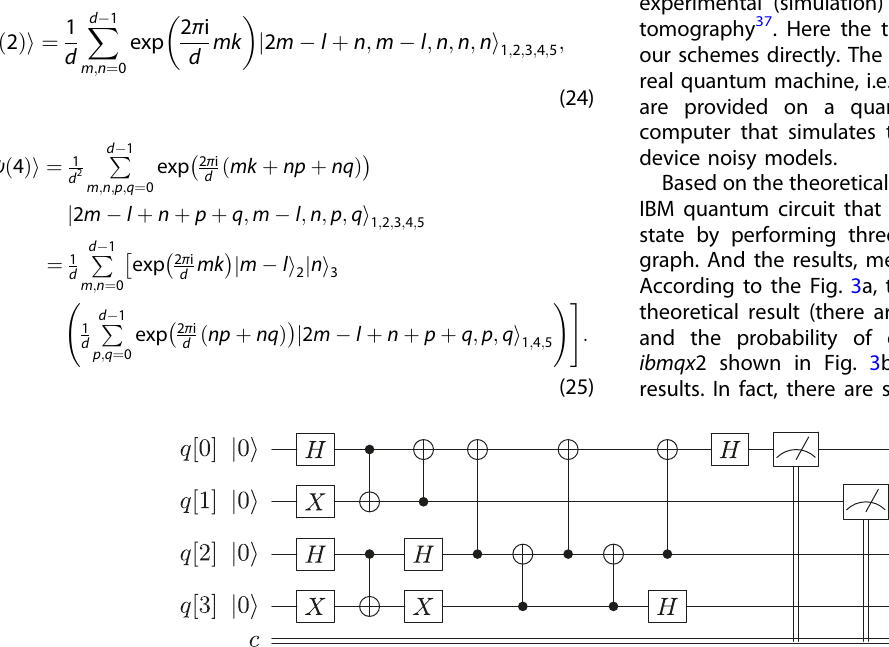
Fig. 2 Quantum circuit for generating Bell state between two parties that are not related at fi rst. The measurements on q [0] and q [3] are in X-basis. The measurements on q [1] and q [2] are in Z-basis.